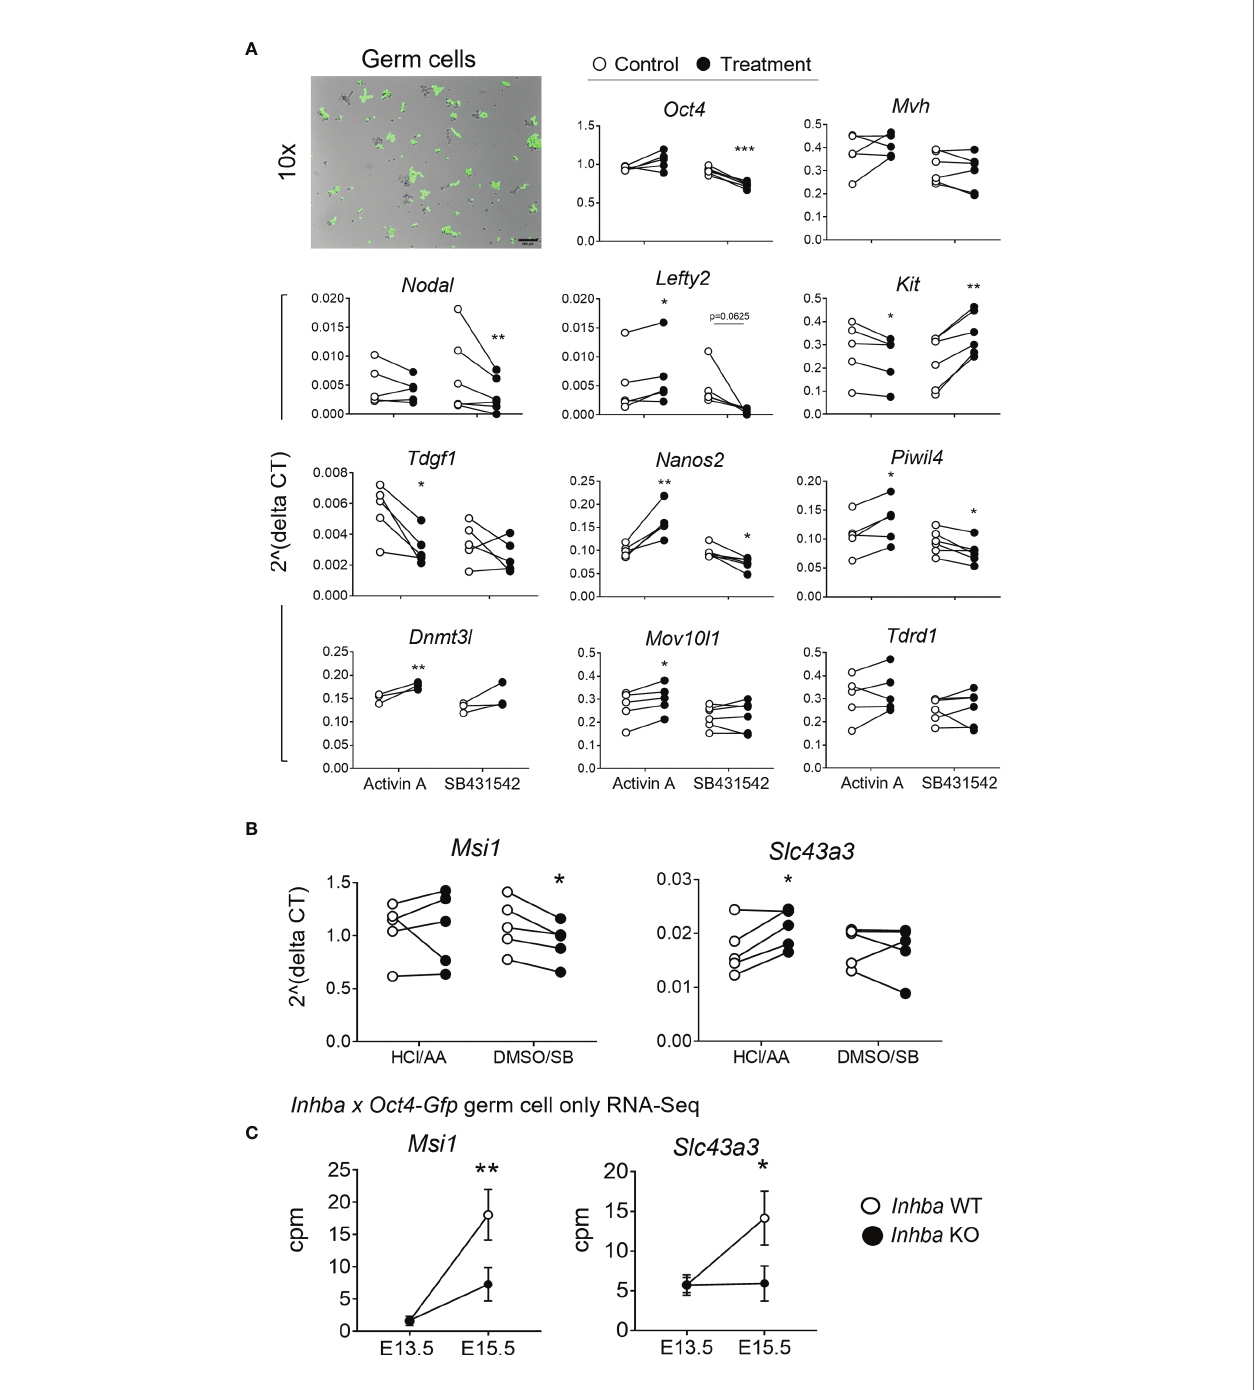
FIGURE 3 | Germ cells can respond directly to activin A modulation. (A) E13.5 germ cells isolated via FACS were cultured with 5 ng/mL activin A or 10 µM SB431542 for 24 hours. Early germ cell and differentiation-associated transcripts were measured by qRT-PCR and normalised to Canx or the mean of Canx and Mapk housekeepers. Data was analysed using the 2^deltaCT method, and each individual experiment is graphed. Following the Shapiro-Wilk normality test, signi fi cance was determined by a paired t-test or Wilcoxon test and indicated by asterisks (*p < 0.05, **p < 0.01, ***p < 0.001). Top left-hand image represents bright fi eld and fl uorescent overlay of Oct4-positive germ cells after 24 hours in culture. Germ cells were lightly adherent, accounting for the overlap shift. Scale bar represents 100 µm. (B) Transcript levels of Musashi-1 ( Msi1 ) and Slc43a3 , as described above. (C) Transcript levels of Msi1 and Slc43a3 in the Inhba x Oct4-Gfp E13.5 and E15.5 WT and KO germ cell RNA-Seq dataset (counts per million; cpm), presented as mean ±